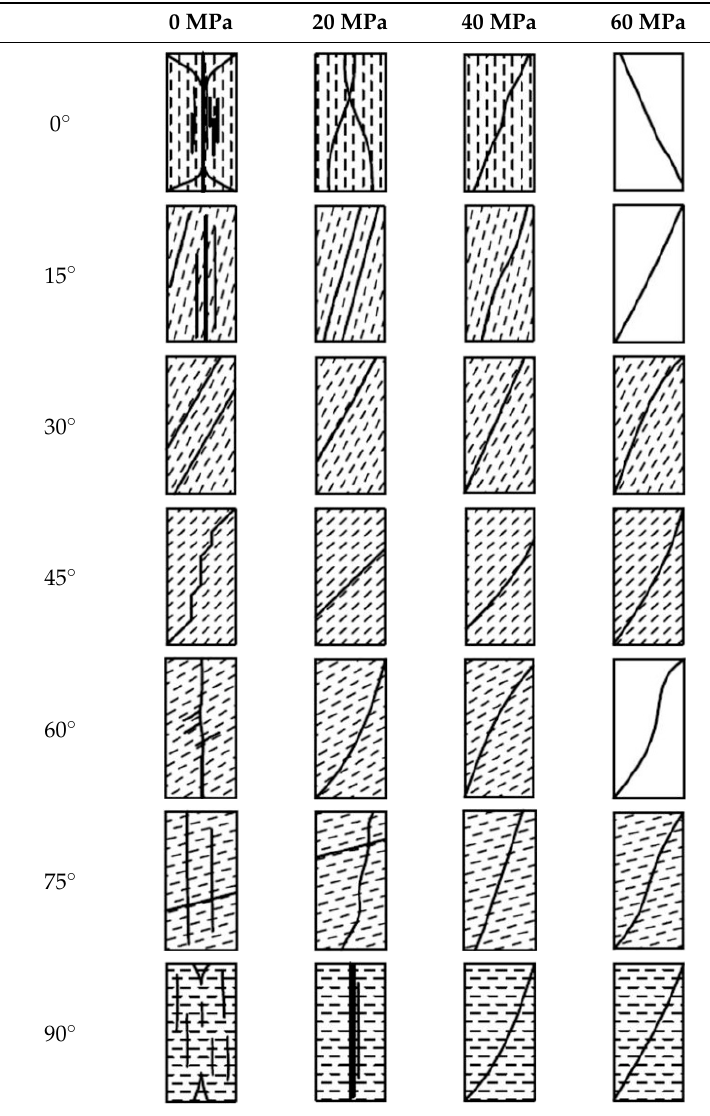
Table 2. Sketches of failure morphology of shale samples under various confining pressure corresponding to different inclination angles ( β ).